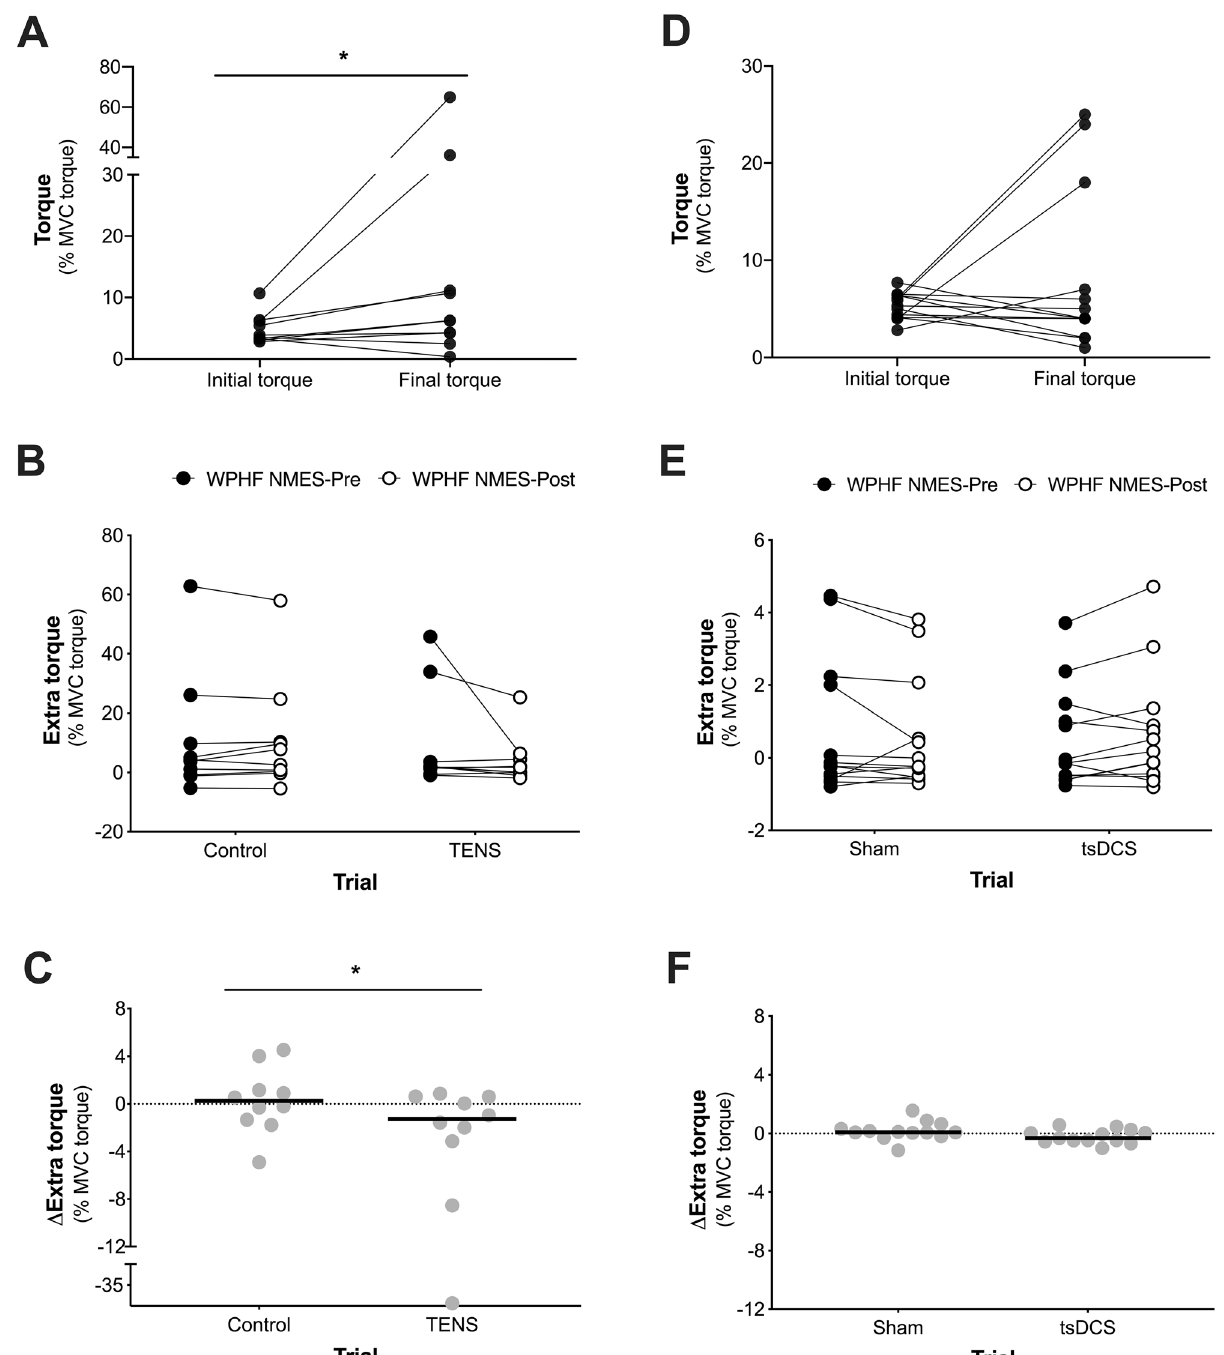
Figure 4. (A) Initial and final torque during WPHF NMES presented for the mean of all WPHF NMES- Pre contractions in the TENS experiment. (B) Extra torque presented before (WPHF NMES-Pre) and after (WPHF NMES-Post) a 15-min period of TENS (TENS trial) or no stimulation (Control trial). (C) Change in extra torque after a 15-min period of TENS (TENS trial) or no stimulation (Control trial). (D) Initial and final torque during WPHF NMES presented for the mean of all WPHF NMES-Pre contractions in the tsDCS experiment. (E) Extra torque presented before (WPHF NMES-Pre) and after (WPHF NMES-Post) a 20-min period of tsDCS (tsDCS trial) or sham stimulation (Sham trial). (F) Change in extra torque after a 20-min period of tsDCS (tsDCS trial) or sham stimulation (Sham trial). Data are presented as individual data points and the line represents the median. *Significant difference between trials ( A : P = 0.037, C : P = 0.013). In TENS experiment (A–C) a significant reduction in extra torque was observed when wide-pulse, high-frequency NMES stimulations were imposed after a bout of TENS compared to the control condition. In the tsDCS experiment (D–F) no significant change in extra torque was observed when a wide-pulse, high-frequency NMES stimulation was imposed after a bout of tsDCS compared to the sham